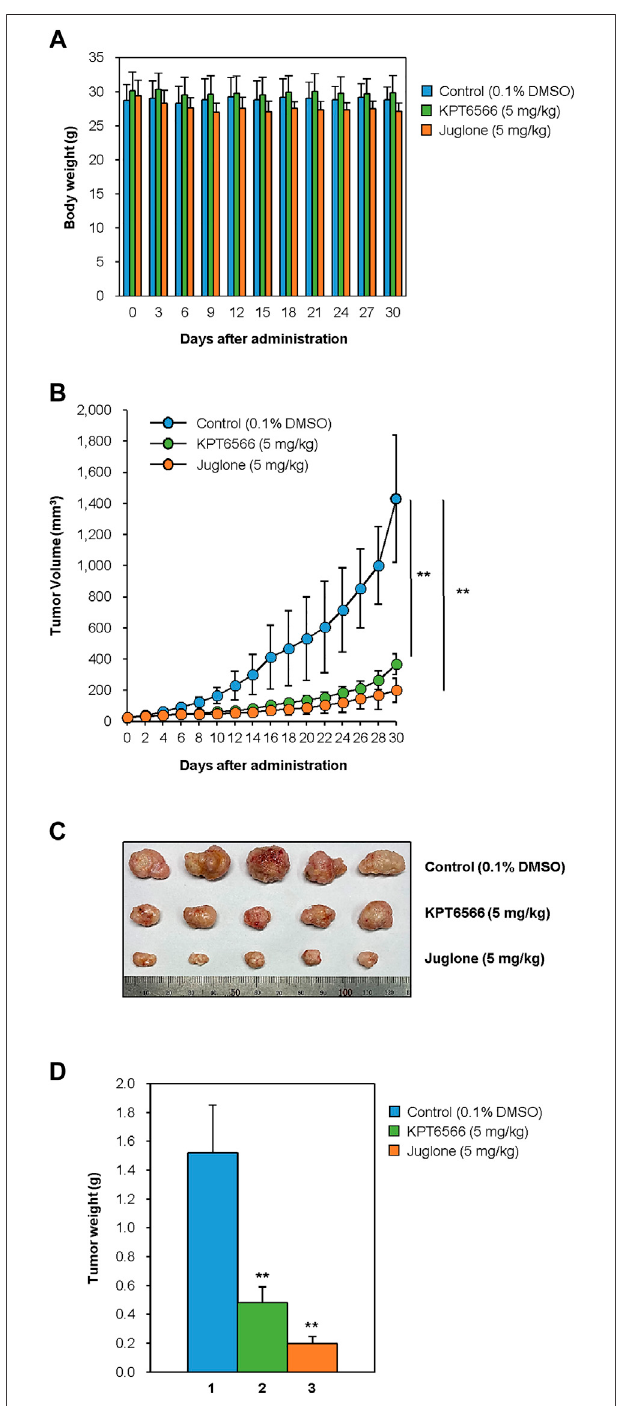
FIGURE 6 | Suppression of CD44 + CD133 + tumor-initiating Caco-2 cell- induced tumor formation by Juglone and KPT6566. (A) Average weight of NSG miceaftertreatmentwithJugloneorKPT6566.Bodyweightwascheckedat3 days intervals to evaluate the potential toxicity of Juglone or KPT6566 throughout the experiment. No signi fi cant weight loss was observed. (B) Reduction in tumor volumeafterinjectionofJugloneorKPT6566.Tumor-bearingmiceweretreatedby intraperitoneal injection of vehicle, Juglone (5 mg/kg), or KPT6566 (5 mg/kg) at ( Continued